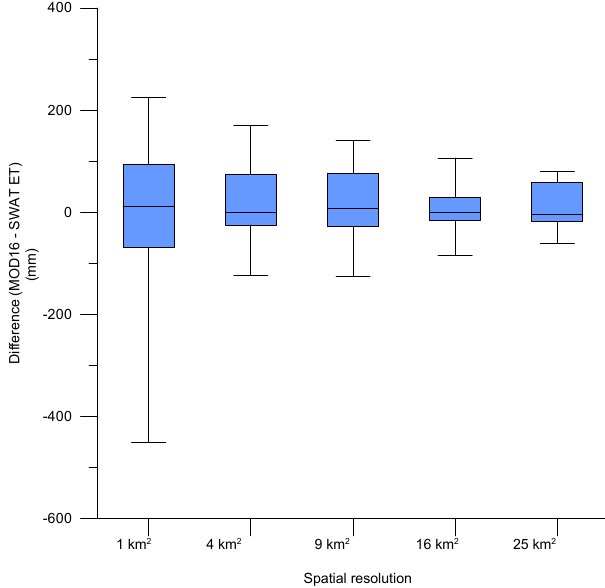
Figure 8. Differences between SWATGEO ET and MOD16 for spa- tial aggregations between 1 and 25km 2 . The bottom, middle and top of the whisker indicate the 25th, 50th and 75th quartiles of the distribution; the lowest and highest bars indicate the minimum and maximum